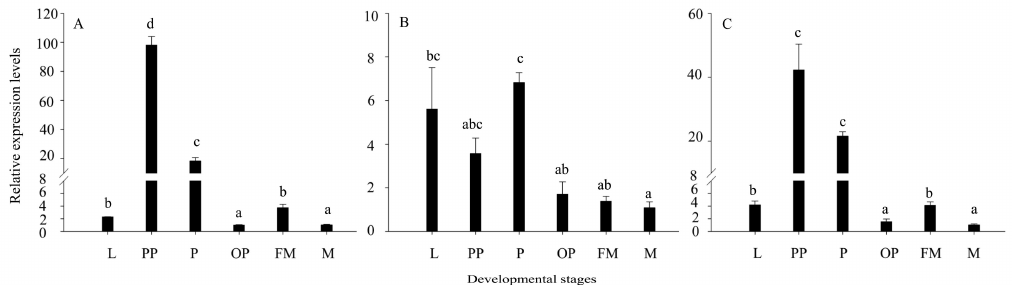
Figure 6. Relative expression levels of LtHSP19.5 , LtHSP20.8 , and LtHSP21.7b in di ff erent developmental stages of L. trifolii . The relative level of HSP expression represented the fold increase as compared with the expression in controls. ( A ) Relative expression levels of LtHSP19.5; ( B ) relative expression levels of LtHSP20.8; and ( C ) relative expression levels of LtHSP21.7b . The data were denoted as mean ± SE. One-way analysis of variance (ANOVA) was used to analyze the relative expression levels of three sHSPs in di ff erent developmental stages. For the ANOVA, data were tested for homogeneity of variances and normality. Di ff erent lowercase letters indicate significant di ff erences among di ff erent developmental stages. Tukey’s multiple range test was used for pairwise comparison for mean separation ( P < 0.05). Abbreviations: FM = females adult; M = males adult; L = third instar larvae; PP = prepupae; P = two-day-old pupae; and OP = ten-day-old